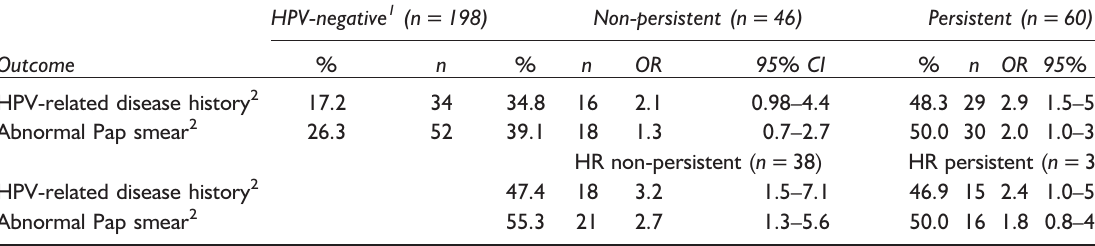
Table 4 HPV-related history, abnormal Pap smear and HPV